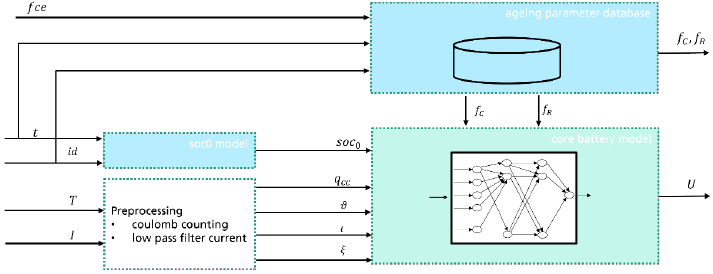
Figure 5. Structure of the fleet model.